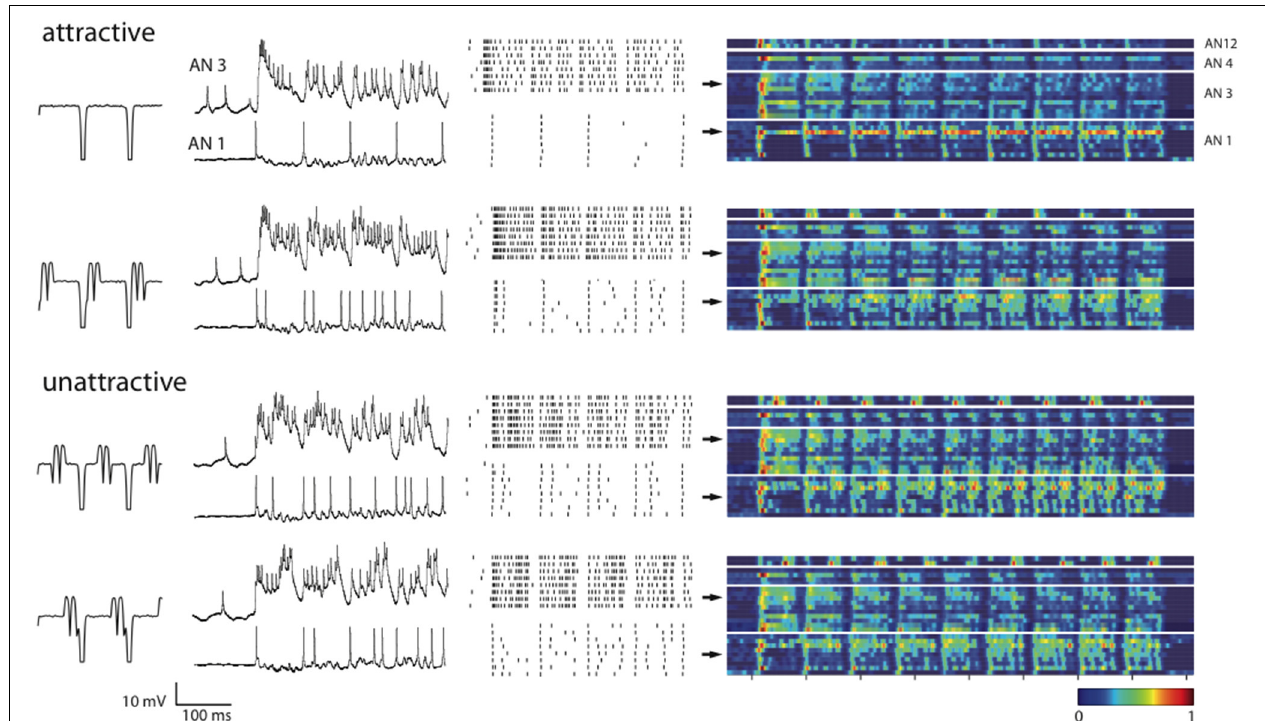
FIGURE 3 | Neuronal responses to all four songs categorized by their behavioral relevance. Voltage traces and spike raster plots (8 trials) in the second and third columns show responses to the first four syllable–pause subunits for two example neurons AN3 and AN1. The fourth column shows trial-averaged firing rates estimated with a Gaussian kernel of width = 4ms